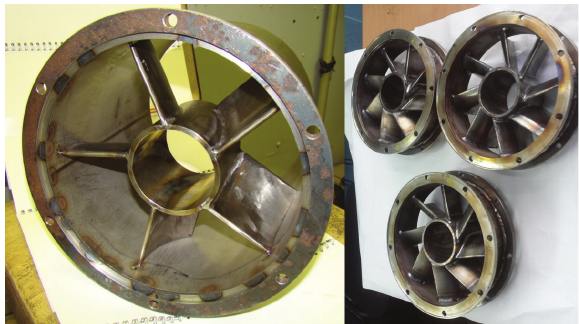
Figure 1. Versions of the SD